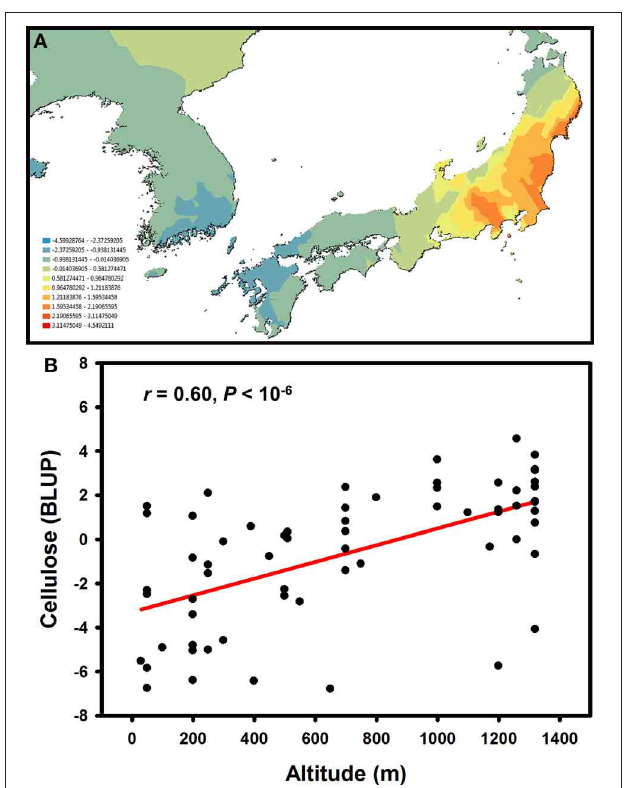
FIGURE 5 | Geographic pattern of genetic variation for cellulose content in a Miscanthus sinensis population (Allison et al., 2011; Slavov et al., 2013). Spatially interpolated (i.e., kriged using Geostatistical Analyst in ArcMap 10, Esri Ltd., Aylesbury, UK) best linear unbiased predictors (BLUPs) of genotypic values for cellulose content in 2-year-old plants (A) and relationship between cellulose content BLUPs and accession source altitudes (B)